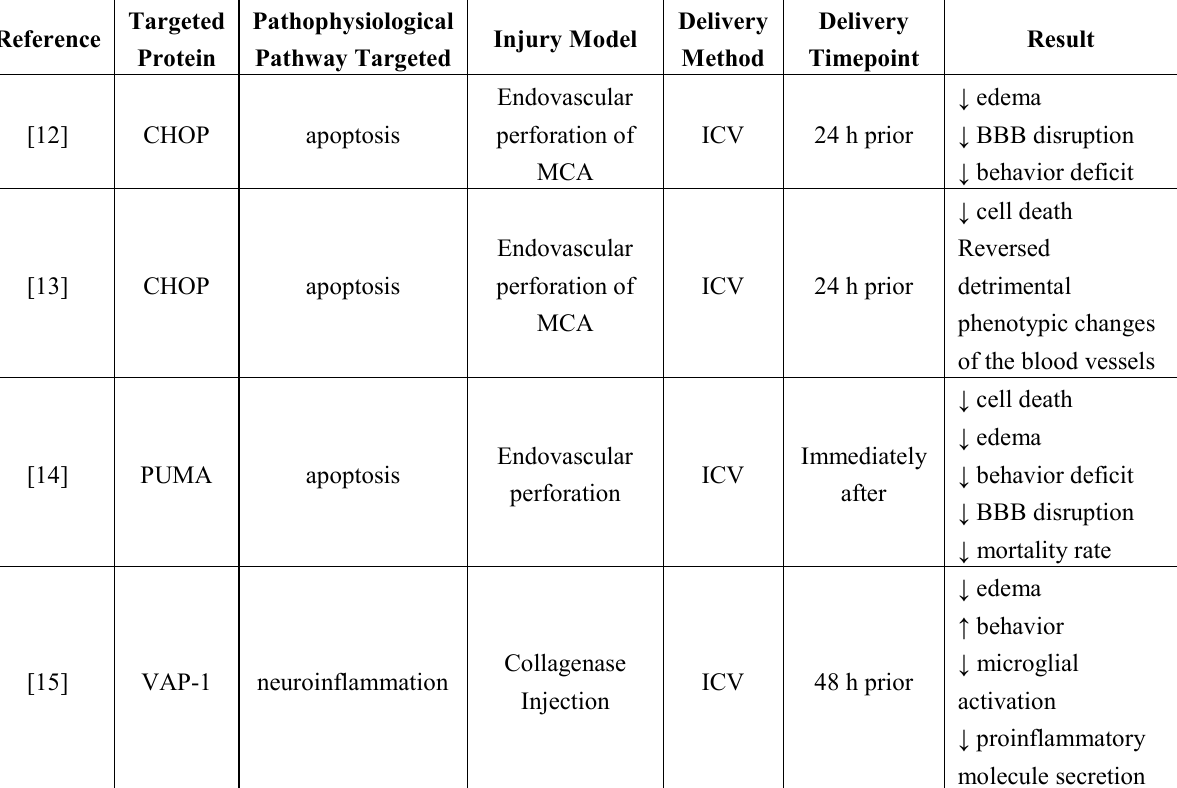
Table 1. Published in vivo usage of RNA interference as a therapeutic tool in Nontraumatic Brain Hemorrhage